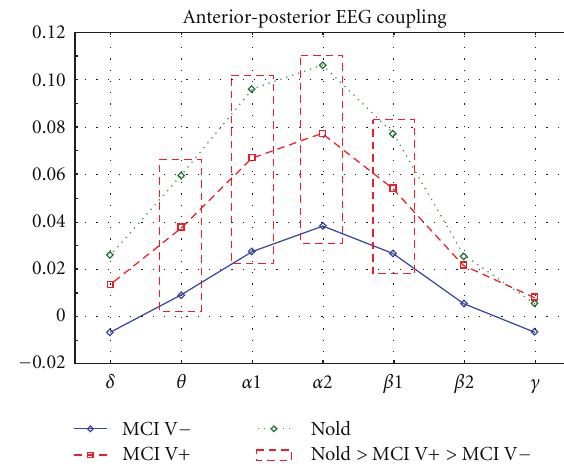
Figure 2: Means of anterior-posterior DTFdi ff values computed in the Nold, MCI V − , and MCI V+ subjects for all frequency bands of interest ( δ , θ , α 1, α 2, β 1, β 2, γ ). These means were obtained averaging the anterior-posterior DTFdi ff values of the three electrode pairs (F3-P3, Fz-Pz, F4-P4), in order to represent a two-way ANOVA interaction ( F (12,690) = 3.65; P < . 000001) between the factors group (MCI V − , MCI V+, Nold) and Frequency